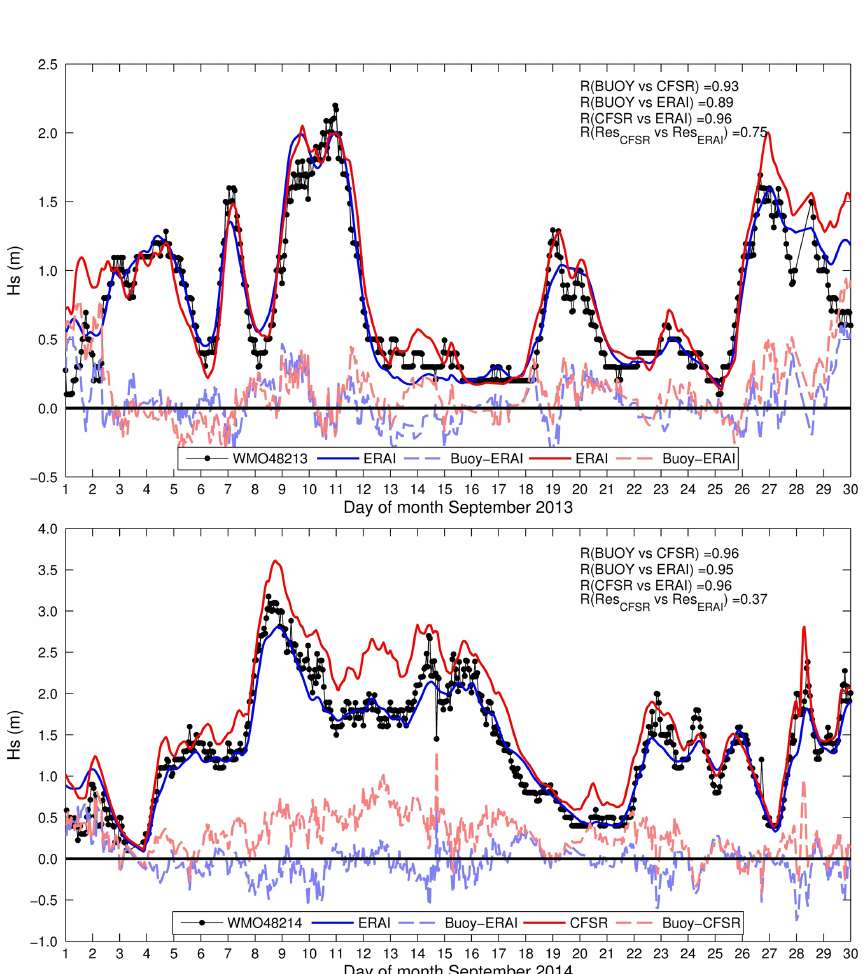
Figure A1. Buoy H s time series for September 2013 (top) and 2014 (bottom). The solid red and blue lines denotes ERAI and CFSR. The dashed lines represent the residual (buoy